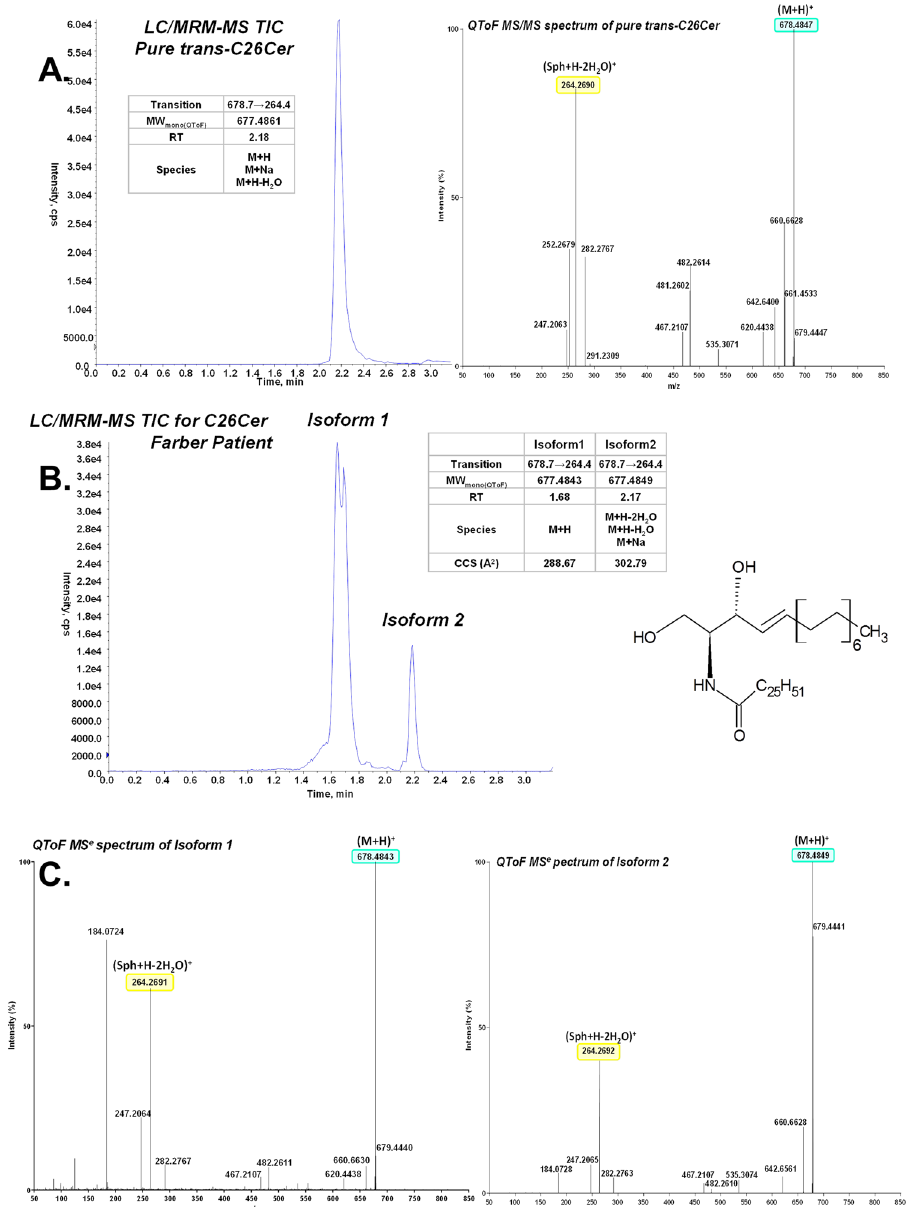
Figure 2. Investigations of the two isoforms of C26:0 ceramide found in DBS extracts: ( A )-TIC of a LC/ MRM-MS analysis and high resolution MS/MS of pure trans -C26:0 ceramide; ( B )-LC/MRM_MS of C26:0 ceramides in DBS extract from a Farber patient and LC/IM-MSe characteristics of the two C26:0 ceramides isoforms. C -MS e mass spectrum of the C26:0 ceramide isoforms in